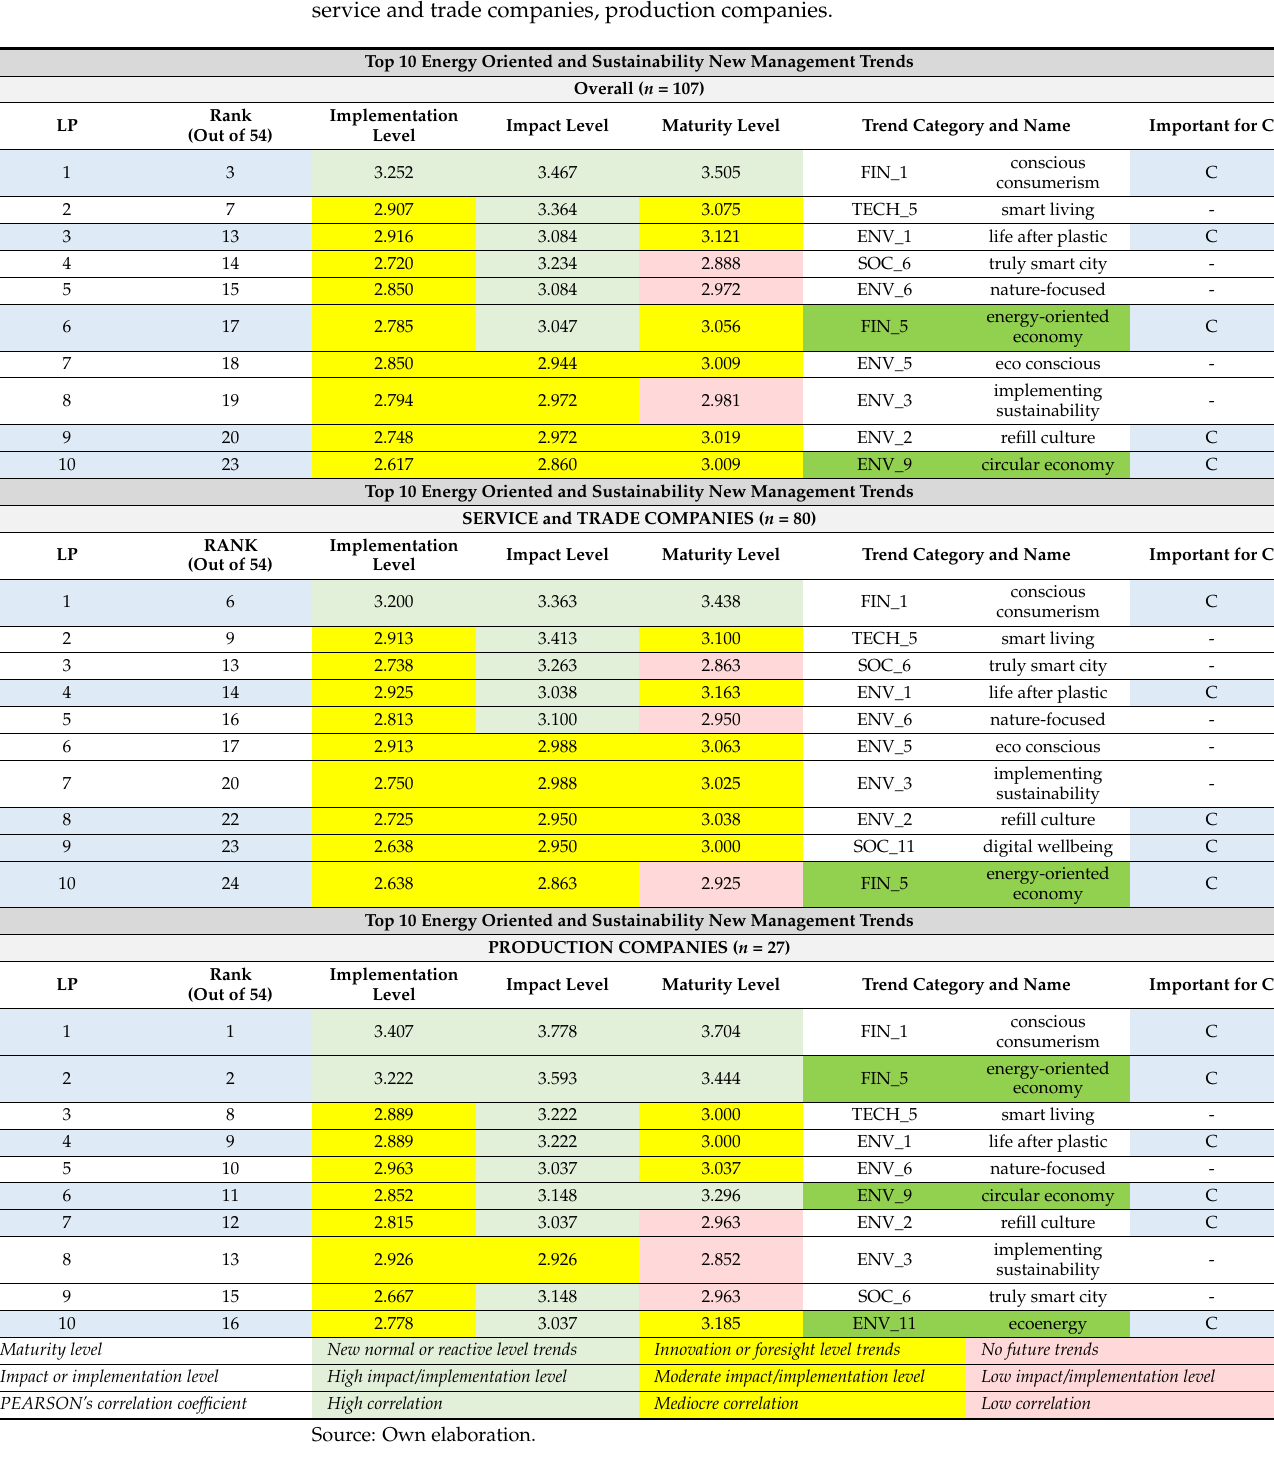
Table 7. Top 10 Energy and sustainability-oriented S.T.F.E.C. SMART management trends—overall, service and trade companies, production